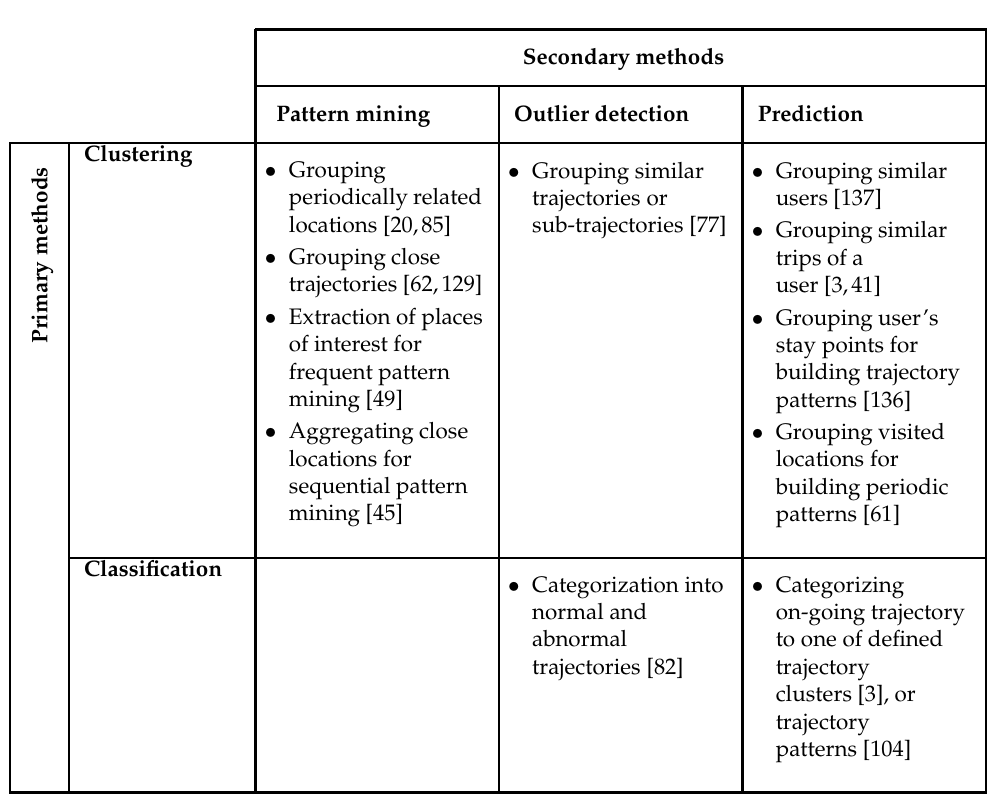
Table 1: Relationships between trajectory mining